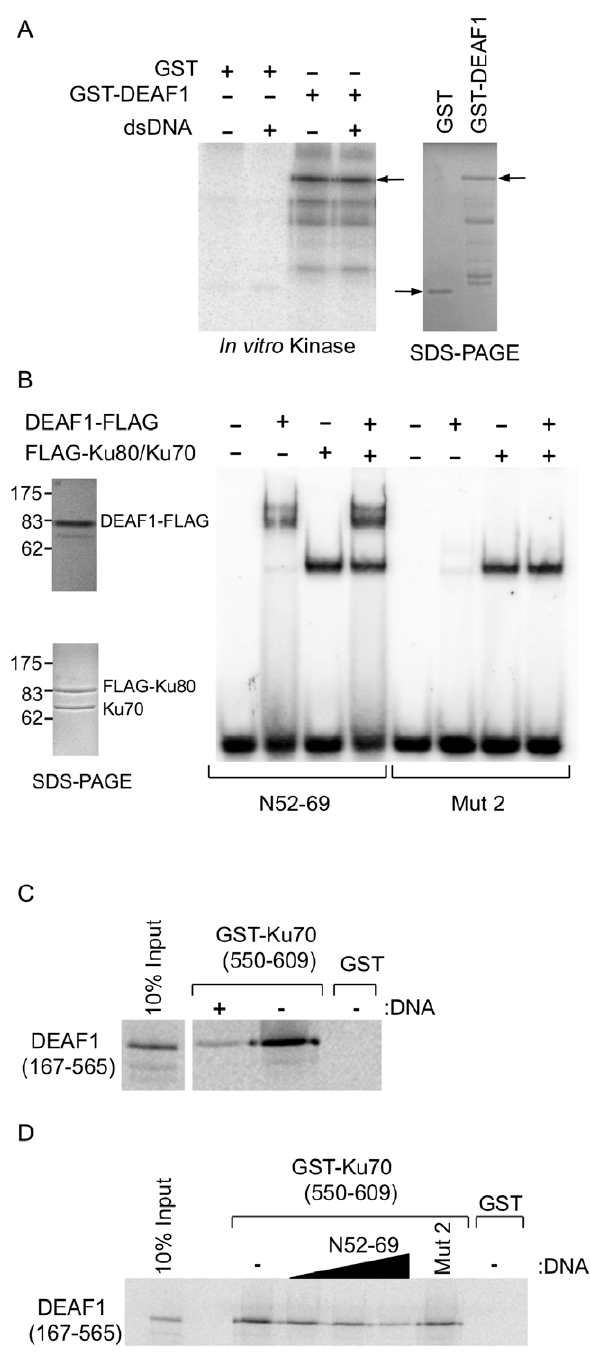
Figure 6. DNA-PK phosphorylates DEAF1, and sequence specific DNA competes with Ku70 for binding to DEAF1. ( A ) DNA-PK and [ c - 32 P]ATP were incubated with GST or GST-DEAF1 bound to glutathione-sepharose beads in the absence ( 2 ) or presence ( + ) of dsDNA (salmon sperm DNA sheared to , 300 bp). Bound proteins were washed, eluted, and separated by SDS-PAGE; and the phosphorylated proteins were detected by autoradiography. Protein levels used in the reactions were assessed in separate SDS-PAGE gels stained with Coomassie blue. ( B ) Electrophoretic mobility shift assays were performed using the indicated FLAG proteins purified from HEK 293T/ 17 cells and either 32 P-labeled dsDNA probes N52-69 (DNA ligand of DEAF1) or Mut 2 (mutated DNA ligand that DEAF1 does not bind). The purities of the proteins used in the assays are shown in Coomassie blue stained SDS-PAGE gels on the left. ( C and D ) GST